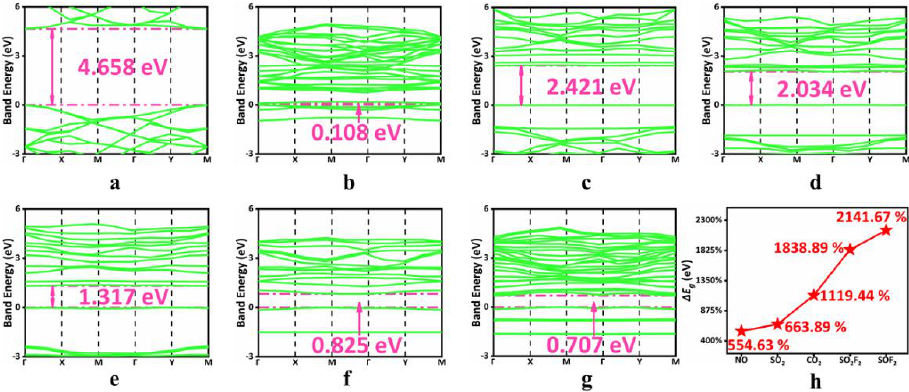
Figure 3. The band energy of ( a ) h-BN monolayer, ( b ) Zr-BN monolayer, ( c ) SOF 2 adsorption system, ( d ) SO 2 F 2 adsorption system, ( e ) CO 2 adsorption system, ( f ) SO 2 adsorption system, ( g ) NO adsorption system. ( h ) ∆ E g of all adsorption systems.